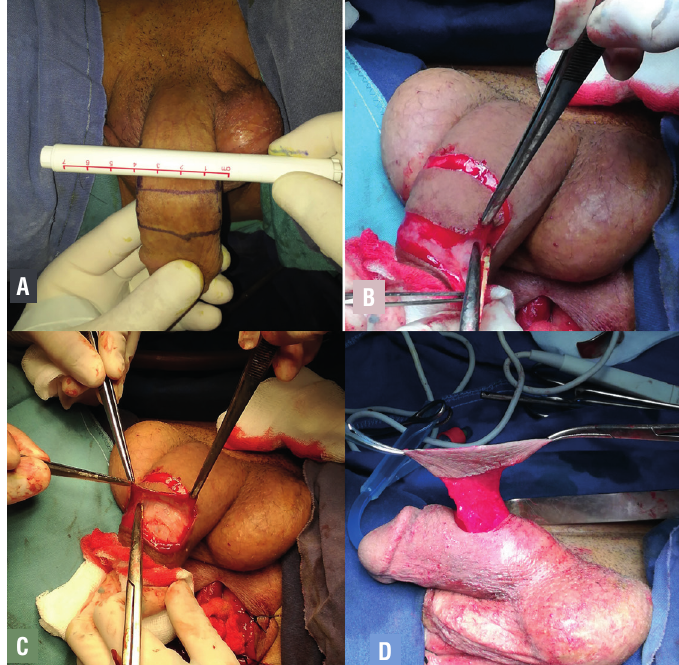
Table 1 - Sample data of the animals submitted to thermoablation using radiofrequency.